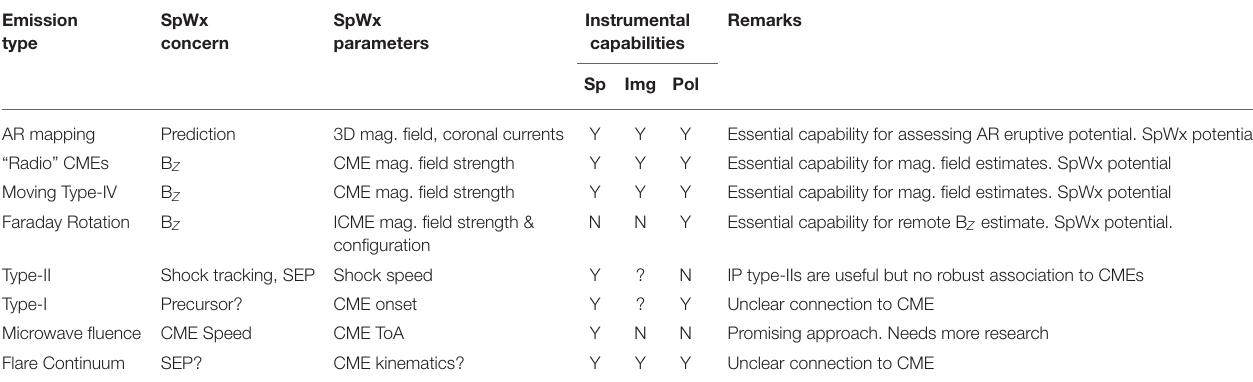
TABLE 1 | Overview of radio emission types with relevance to SpWx CME research. Emission